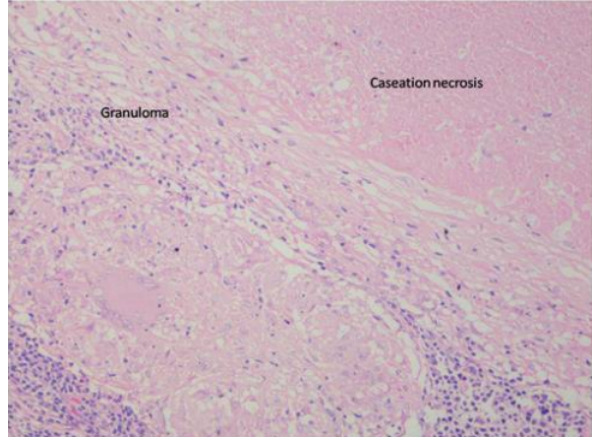
Figure 5: Showing granuloma with Langhan’s giant cells and caseation necrosis